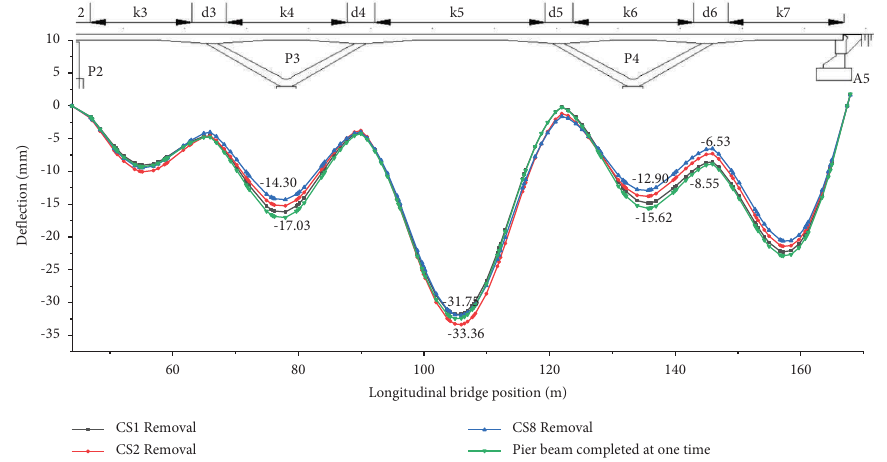
Figure 6: Diferent defections for the removal of temporary supports at diferent